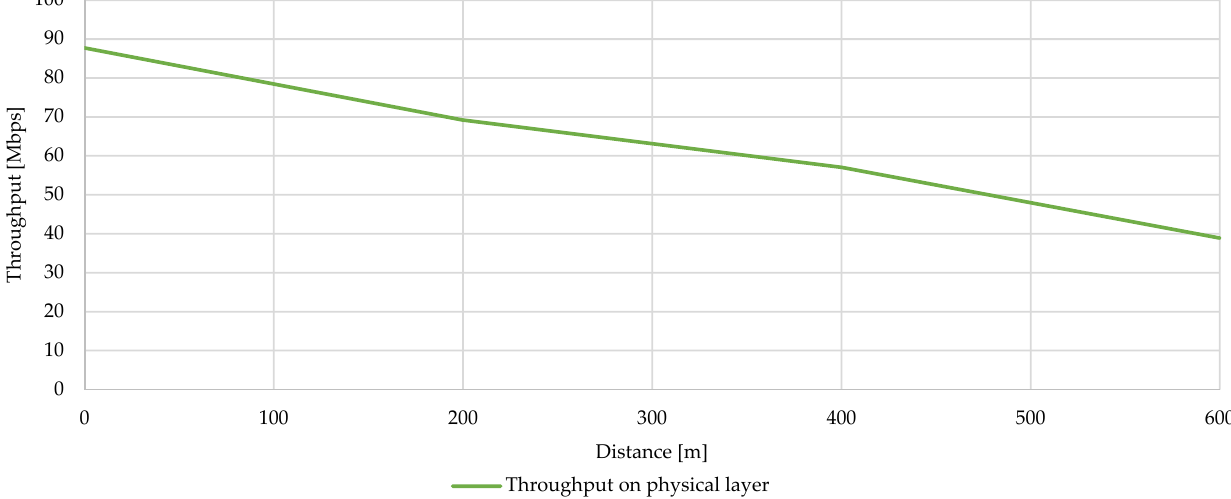
Figure 13. Calculated throughput at the physical layer.